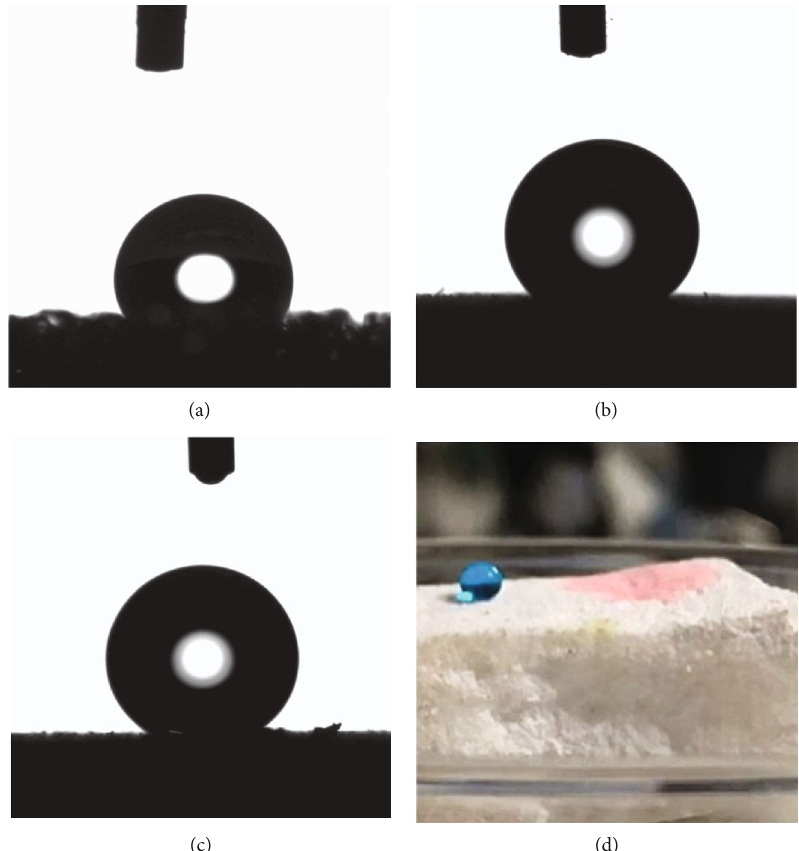
Figure 5: The water contact angle of sponge before modi fi cation (a), the water contact angle of the sponge after immersion in PDMS solution (b), the water contact angle of the sponge after loading with hydrophobic aerogel particles (c), and water (blue) and oil (dichloroethane, red) droplets on the modi fi ed sponge